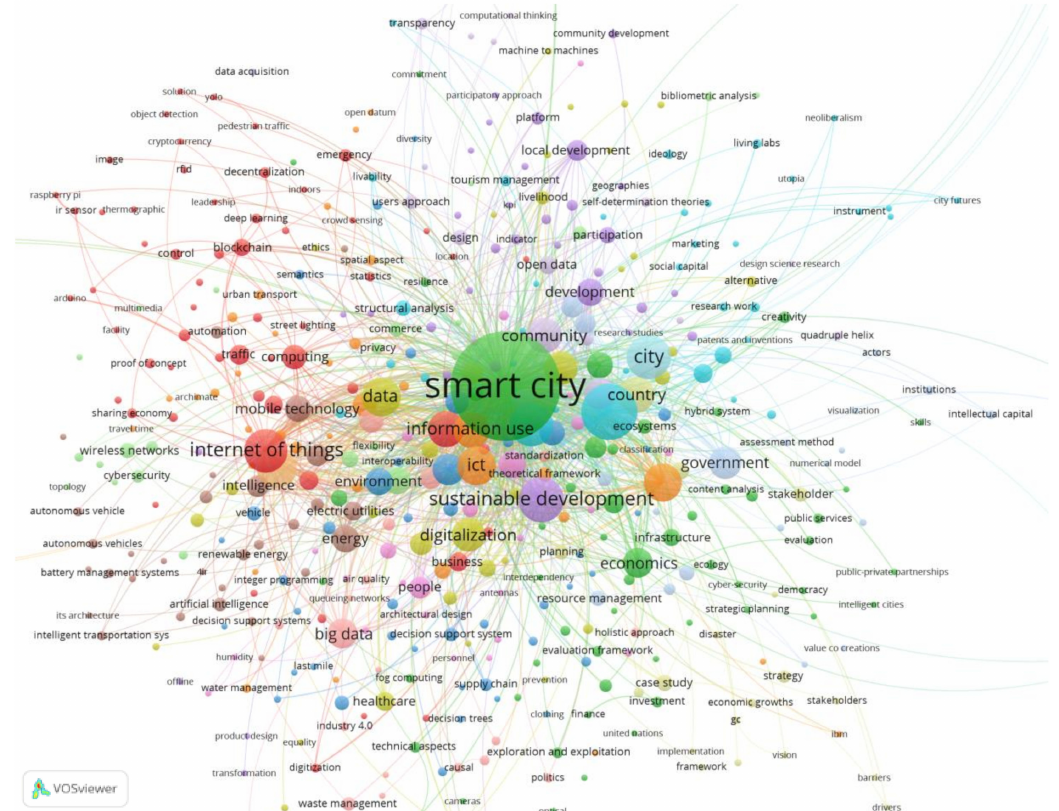
Figure 11. The visualization effect of data cleaning